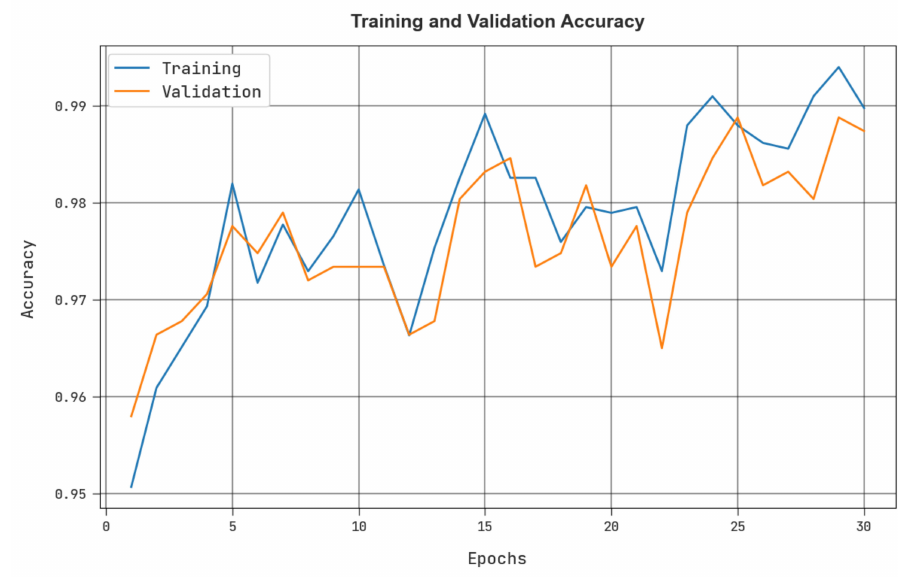
Figure 9. TR acc and VL acc analysis of MRFOTL-GCDC system.